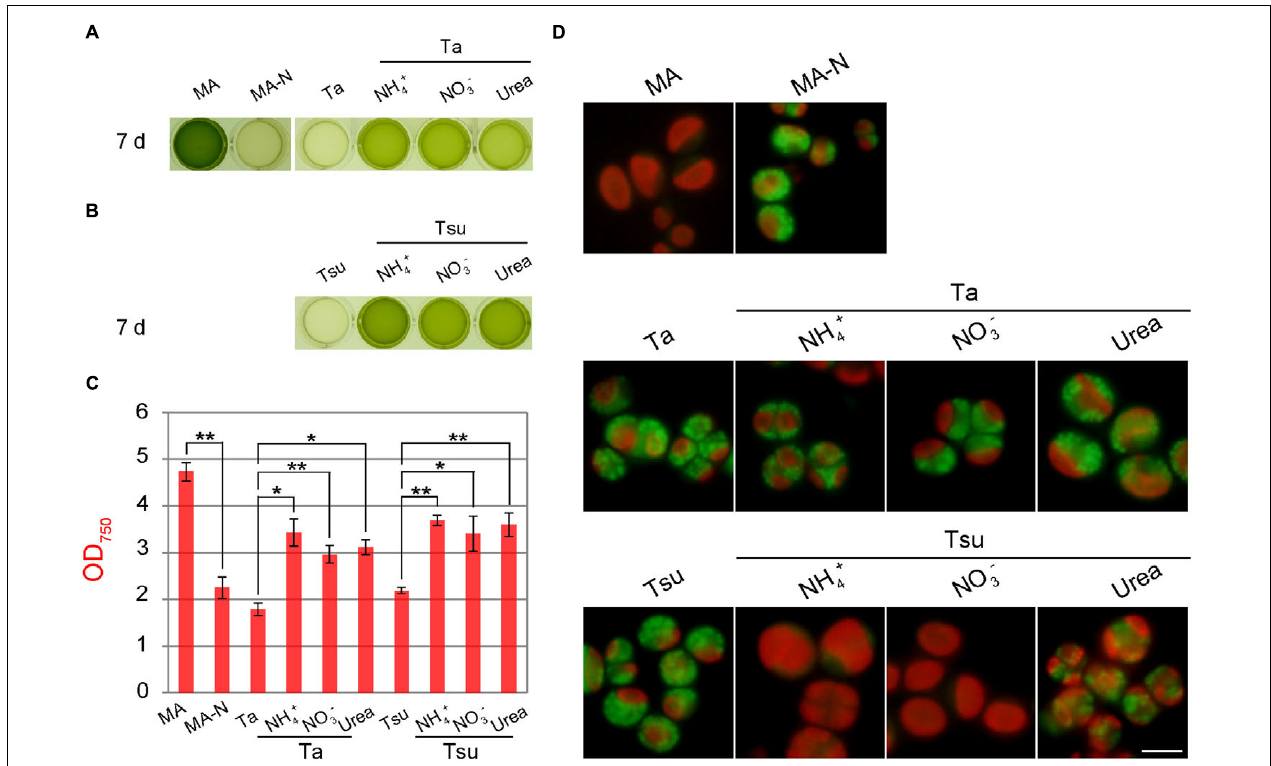
FIGURE 5 | Growth of Pseudochlorella sp. YKT1 cells in MA, MA-N and media derived from acidic hot spring waters supplemented with different nitrogen sources (pH 2.0). Cells cultured in MA (OD 750 of 1.0–2.0) were collected by centrifugation, gently resuspended into the respective media to give an OD 750 of 1.0 and then cultured for 7 days. (A, B) Photographs of the cultures in a 24-well plate at 7 days after inoculation. (C) OD 750 of cultures at 7 days after inoculation. The bar indicates the standard deviation of three independent experiments. Significance was calculated by t -test. ∗ Statistically significant differences at P < 0.05; ∗∗ statistically significant differences at P < 0.01. (D) Micrographs of cells that were cultured in the respective media for 7 days. Scale bar = 5 µ